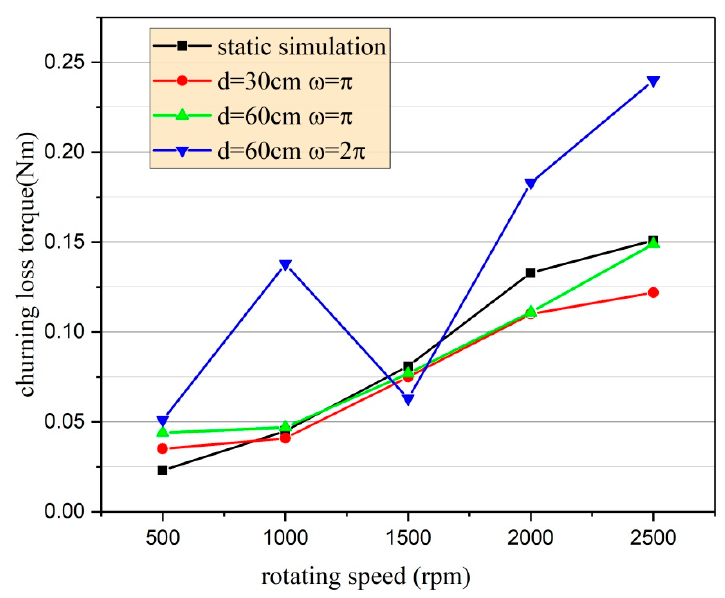
ff erent simulation